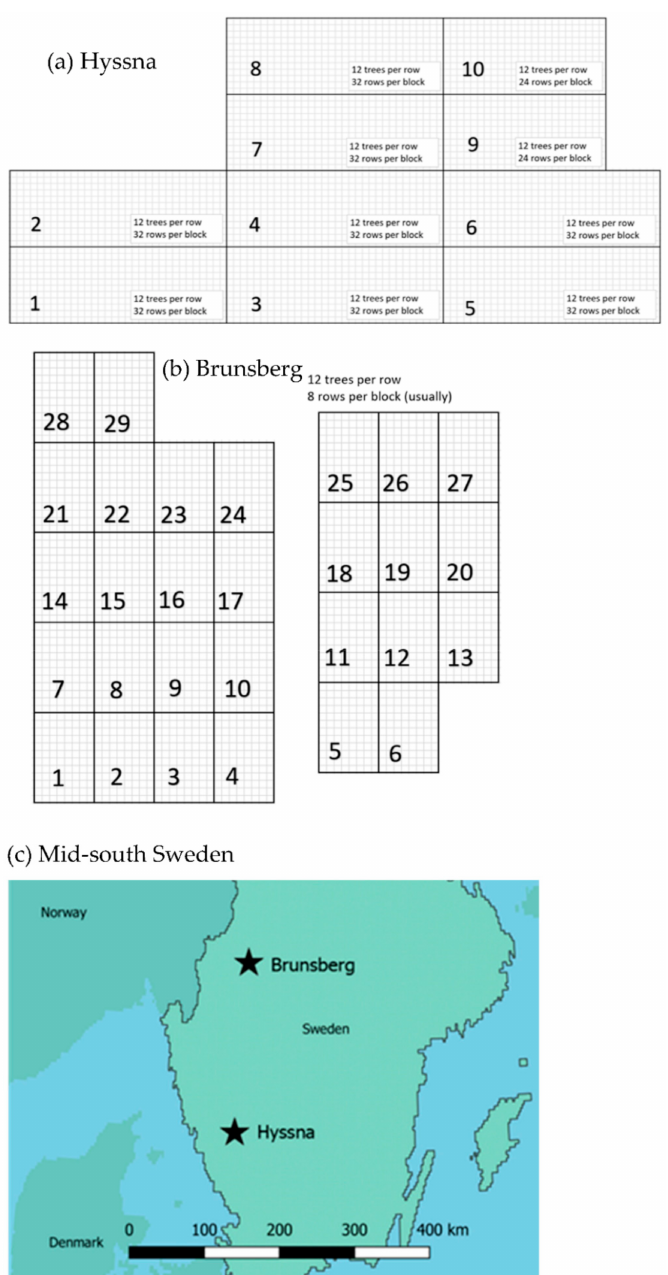
Figure 1. Site layout with block numbers for ( a ) Hyssna and ( b ) Brunsberg, each square is 2 × 2 m. Trial locations within Sweden ( c ) marked with stars and labelled. Country names are a smaller font size, blue area is sea, and grey outline is Sweden’s